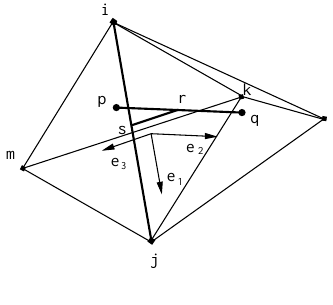
Figure 2. Tree-dimensional